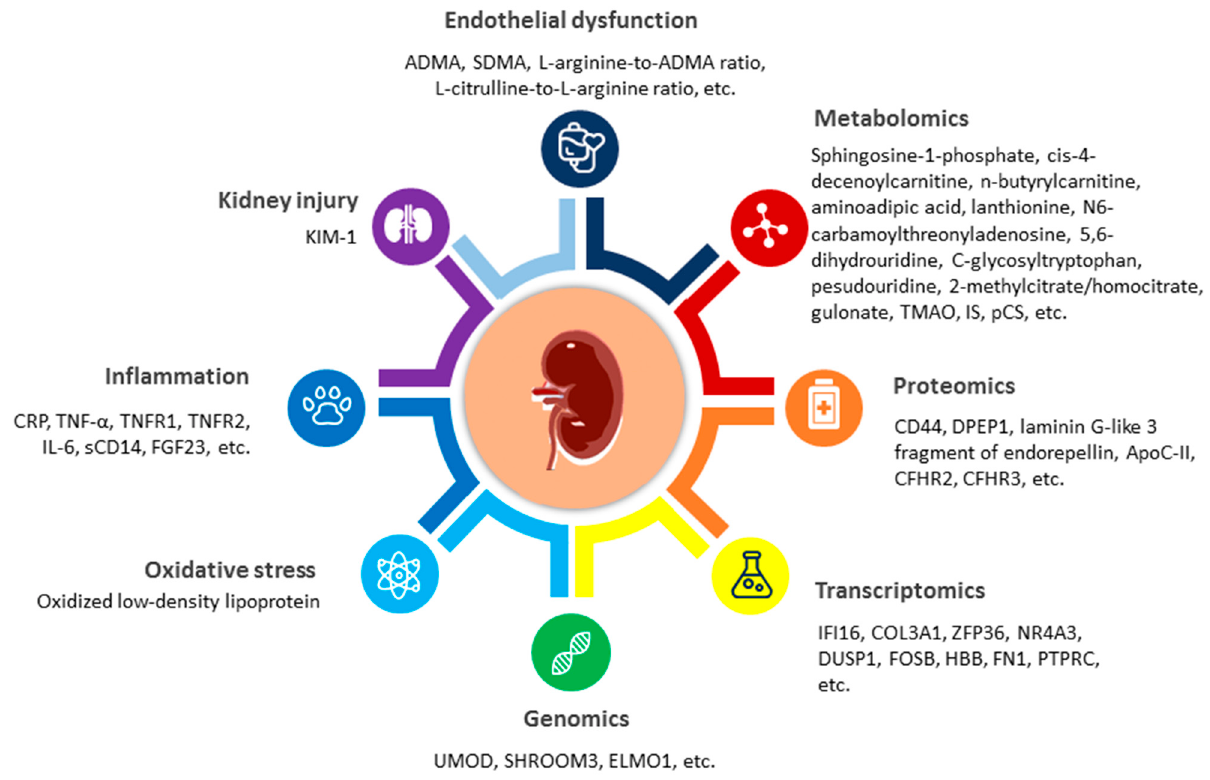
Figure 3. Different types of potential biomarkers in pediatric chronic kidney disease (CKD) for cardiovascular (CVD) risk. ADMA = asymmetric dimethylarginine; SDMA = symmetric dimethylarginine; KIM-1 = kidney injury molecule-1; CRP = C-reactive protein; IL-6 = interleukin-6; TNF- α = tumor necrosis factor- α ; TNFR1 = TNF- α receptor type 1; TNFR2 = TNF- α receptor type 2; sCD14 = soluble CD 14; FGF23 = fibroblast growth factor 23; UMOD = uromodulin, SHROOM3 = shroom family member 3; ELMO1 = engulfment and cell motility 1 gene; DPEP1 = dipeptidase 1; ApoC-II = apolipoprotein II; CFHR2 = complement factor H-related protein 2; CFHR3 = complement factor H-related protein 3; TMAO = trimethylamine-N-oxide; IS = indoxyl sulfate; pCS = p-cresil sulfate.